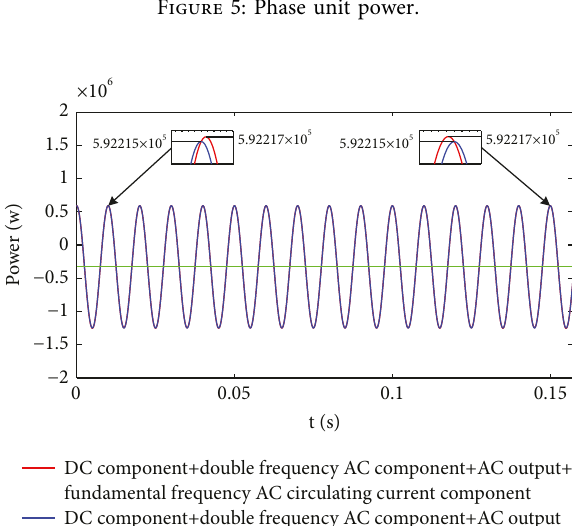
Figure 5: Phase unit power.